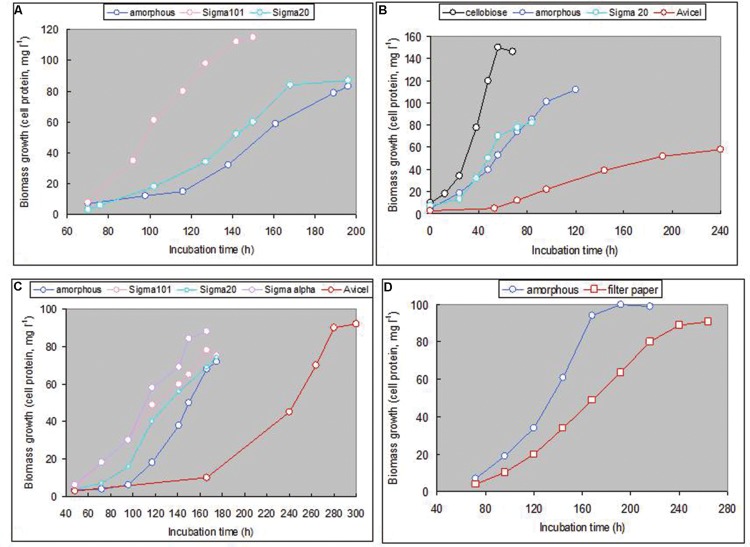
Growth of natronarchael strains on various forms of cellulose at 4 M Na+, pH 9.5 and 37°C. (A) strain AArcel1, (B) strain AArcel2, (C) strain AArcel7, and (D) strain AArcel9.